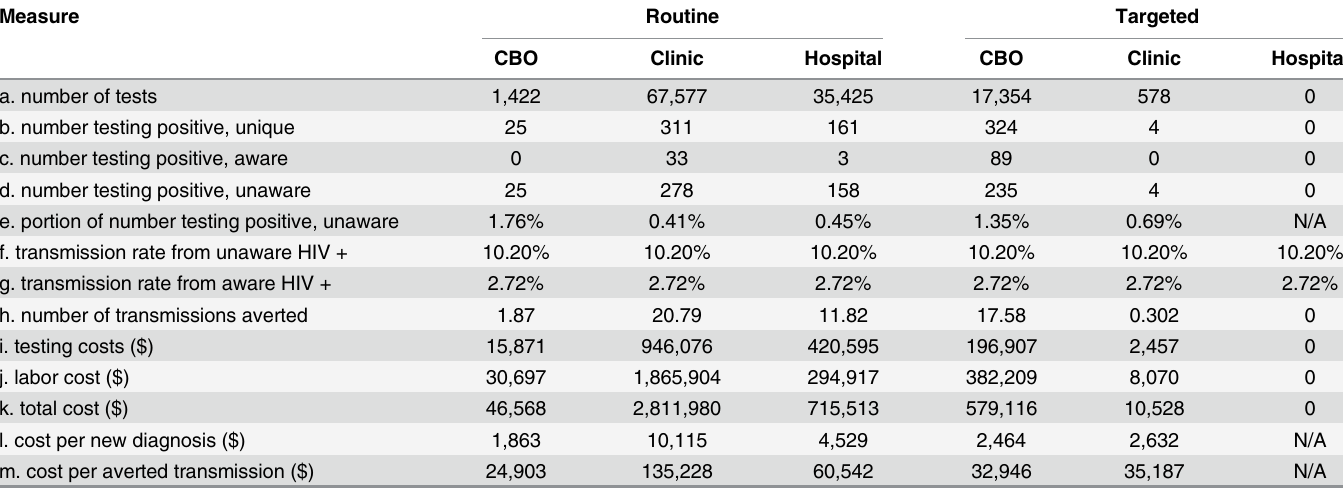
Table 4. Cost Effectiveness of Routine and Targeted HIV Testing by Site Type, Washington, DC,